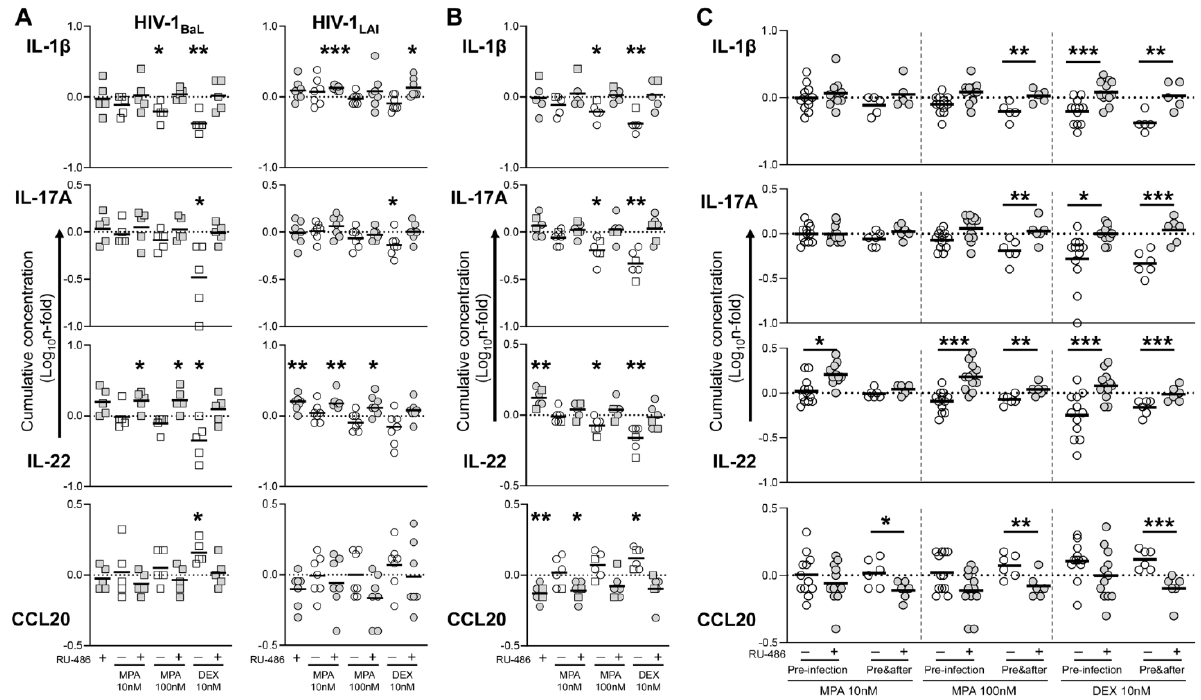
Figure 3. Cytokine production in HIV-infected tonsillar tissue explants treated with steroid hormones. Cytokine levels were measured in culture supernatant of tonsillar tissue explants treated with medroxyprogesterone acetate (MPA) and dexamethasone (DEX) at the indicated concentrations, in the presence or the absence of mifepristone (RU-486) at 1 μM, prior to infection (pre-infection, ( A )), or before and after ( pre& after, ( B )) infection with HIV-1, as indicated in Figures 1 and 2. ( A ) N-fold change in cumulative cytokine production (Day 3 to Day 12 post-infection) of explants infected with HIV-1 BaL (squares, n = 5) and HIV-1 LAI (dots, n = 7) compared to donor-matched untreated explants (VEH). Lines indicate mean values. Asterisks denote a statistically significant difference with VEH (one sample t test,* p < 0.05, ** p < 0.01, *** p < 0.001). ( B ) N-fold change in cumulative cytokine production (Day 3 to Day 12 post-infection) of explants infected with HIV-1 BaL (squares, n = 1 – 2) and HIV-1 LAI (dots, n = 4) compared to donor-matched untreated explants (VEH). Lines indicate mean values. Asterisks denote a statistically significant difference with VEH (one sample t test,* p < 0.05, ** p < 0.01, *** p < 0.001). ( C ) N-fold change in cumulative cytokine production of explants treated with the indicated MPA concentration prior to infection (pre-infection, n = 12) or before and after infection ( pre& after, n = 5 – 6) compared to donor-matched VEH. Lines indicate mean values. Asterisks denote a statistically significant difference between each treatment group and the respective RU-486-treated control (two-way ANOVA with Sidak ’ s multiple comparisons test, * p < 0.05, ** p < 0.01, *** p < 0.001).